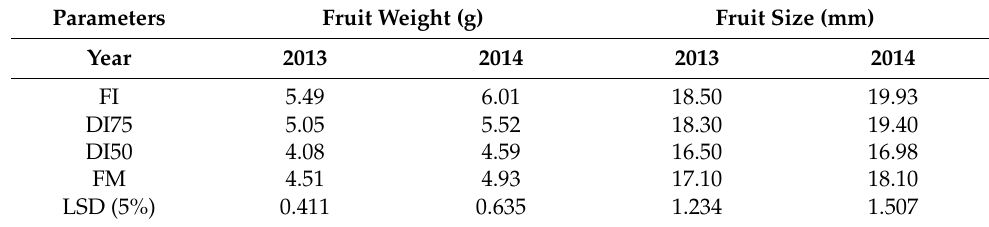
Table 2. Olive fruit yield and quality under irrigation strategies for the study periods 2013 and 2014. Parameters